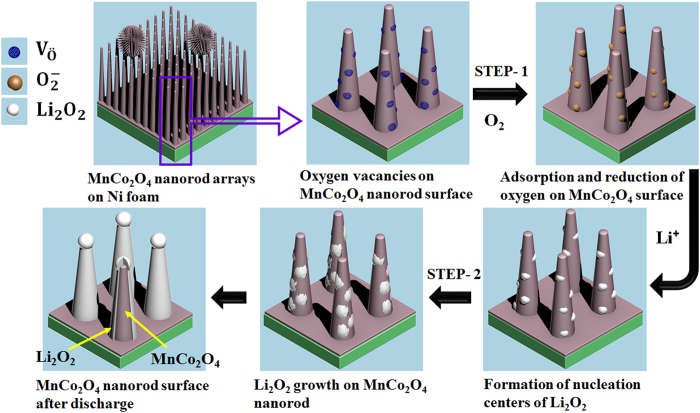
Schematic illustration of the nucleation and growth of Li2O2 on the MnCo2O4 nanorod array.